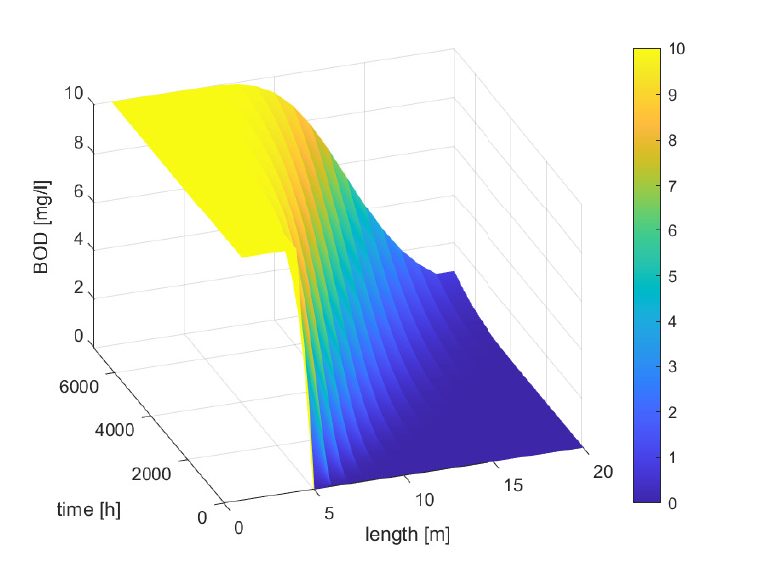
Figure 10. BOD distribution excluding diffusion, no self-cleaning process for V = 0.001. The effect of velocity when diffusion is included and omitted at different velocities is shown in Figure 11. Excluding diffusion after the introduction of a pollutant, the pollutant concentration is higher than when diffusion is allowed for, which results in a faster decomposition of BOD.